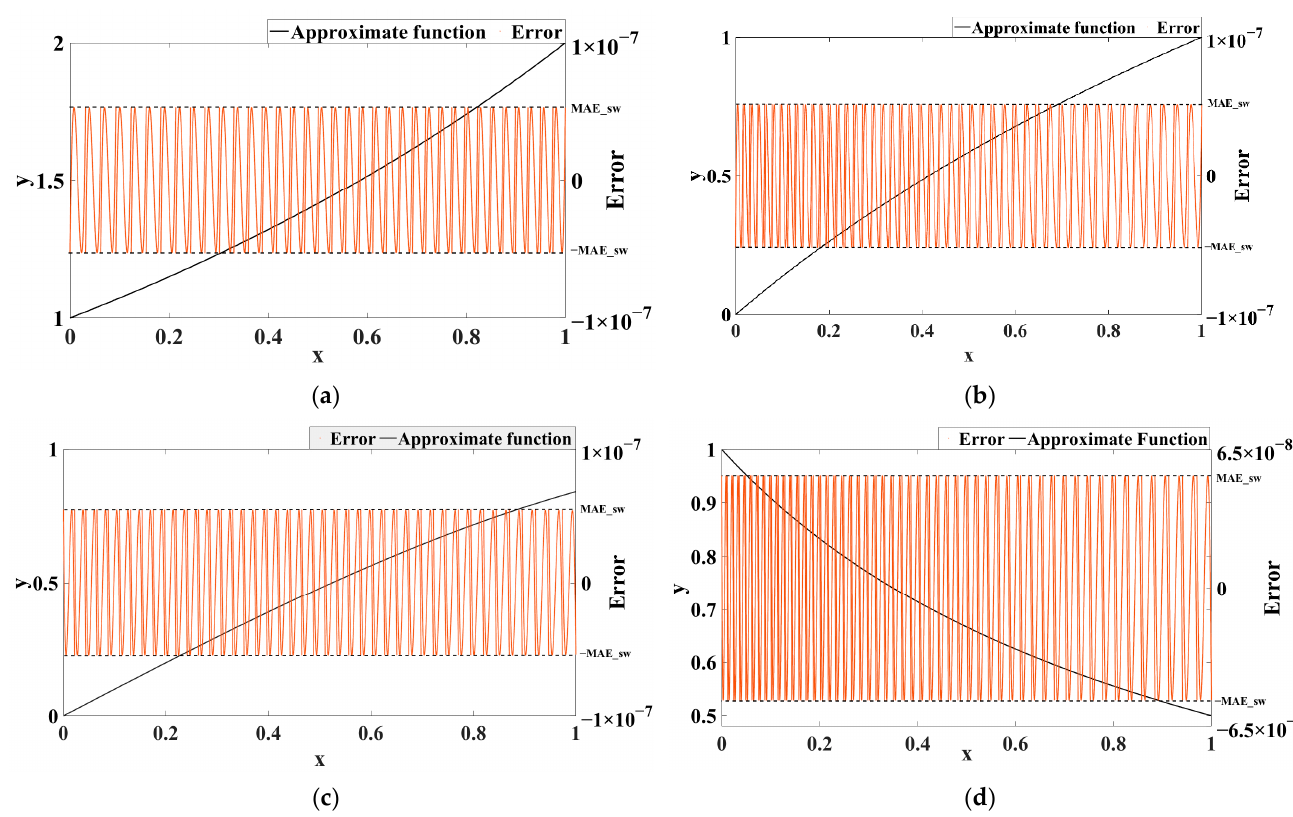
Figure 6. Error-flattening distribution diagram for different target functions in [0, 1). ( a ) 2 (cid:2934) ; ( b ) 𝑙𝑜𝑔 (cid:2870)(cid:2869)(cid:2878)(cid:3051) ; ( c ) sin (x) ; ( d ) 1/ ( 1 + x )